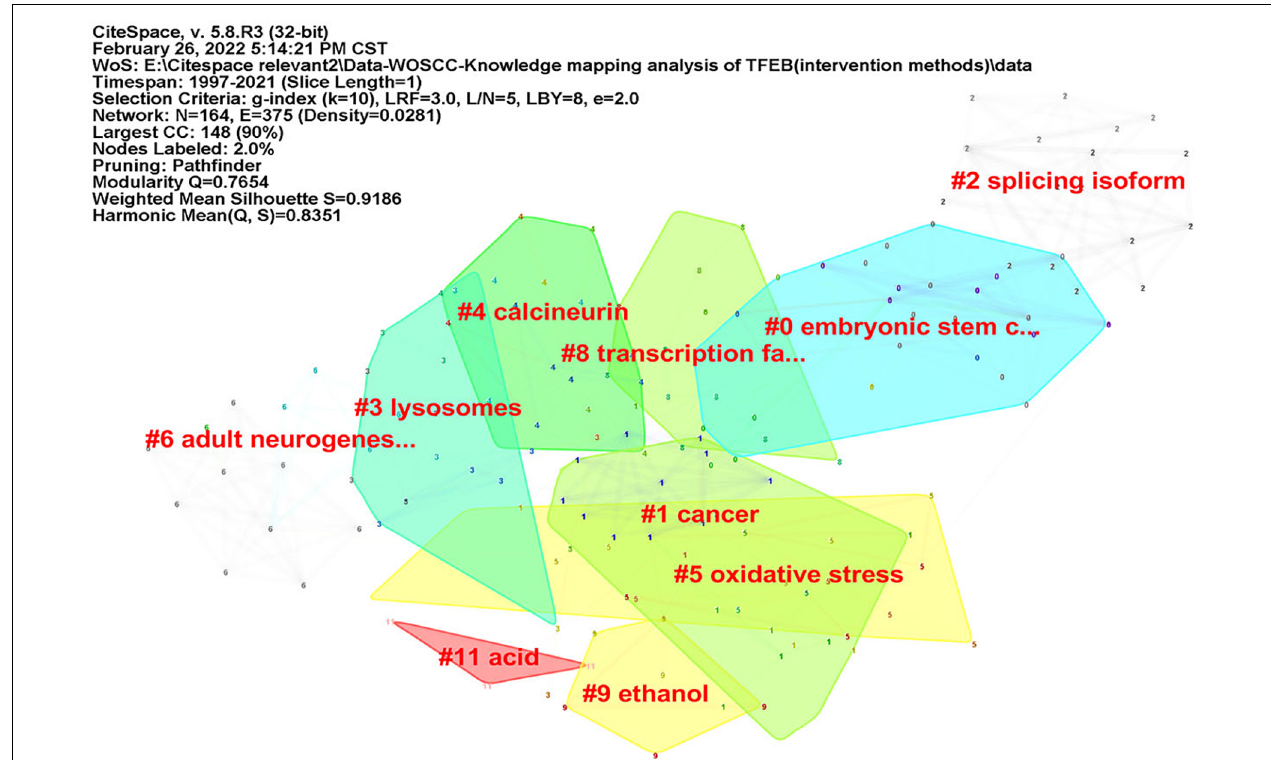
FIGURE 7 | Keyword clusters map of TFEB about “intervention